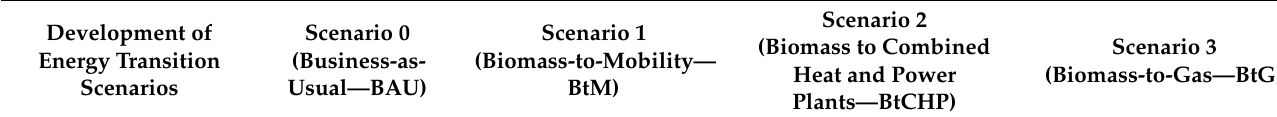
Table 4. Overview of investigated scenarios for St. Margareten for the year 2050.